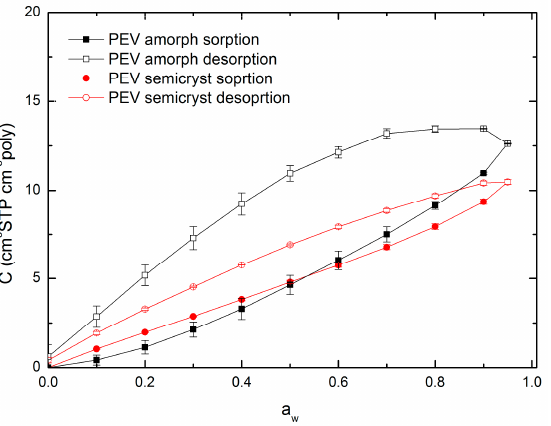
Figure 7. Sorption hysteresis at 20 °C for amorphous and semicrystalline PEV (two replicates for each point). Lines are drawn to aid the eye and do not represents model fits.